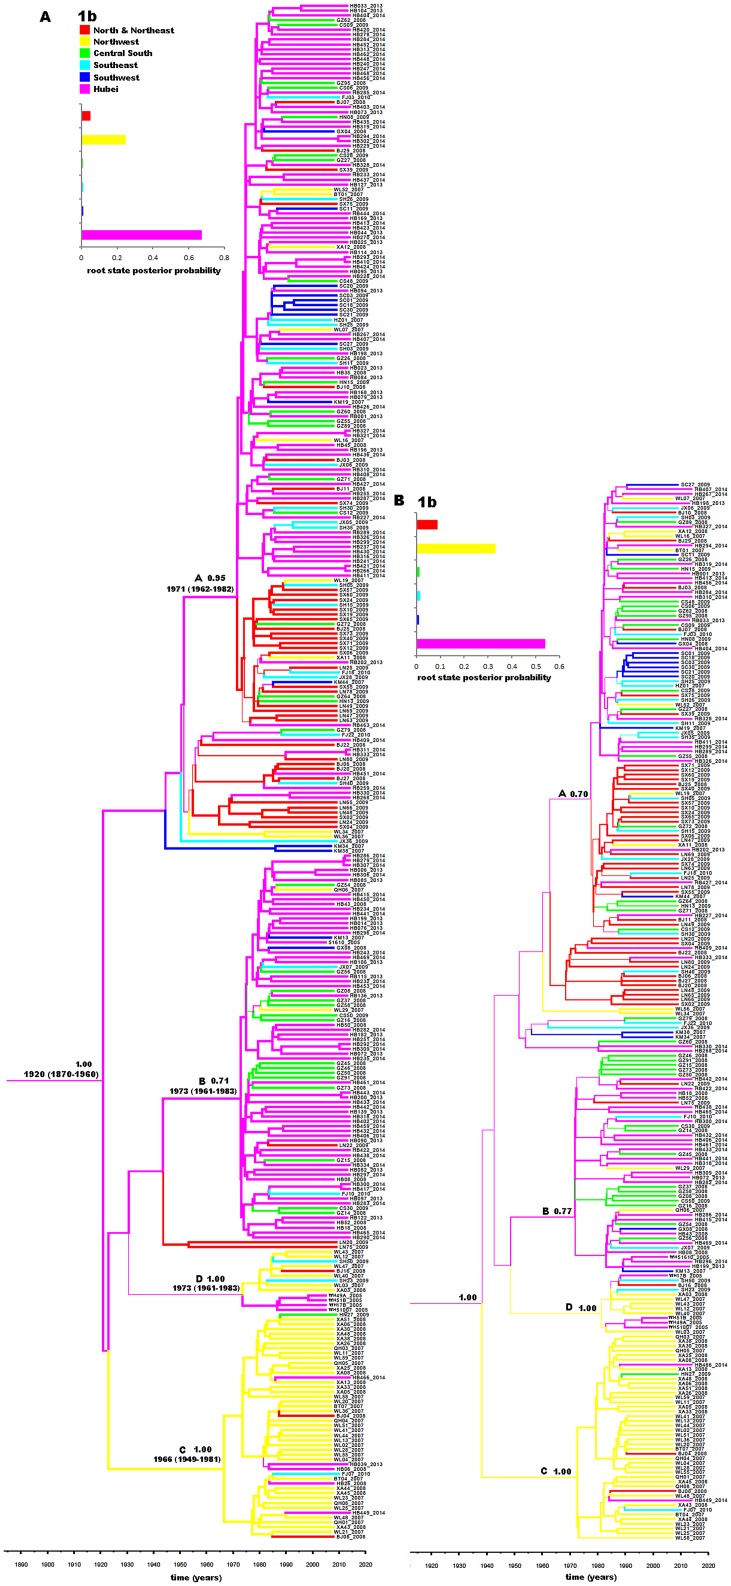
Phylogeographic tree reconstructed with the partial Core-E1 sequences of subtype 1b isolates.(A) A total of 333 subtype 1b sequences were used to generate the phylogeographic tree: 147 obtained in this study, indicated by HB and three digits (e.g., HB001), 5 from intravenous drug users (IDUs) in Wuhan city of Hubei Province, indicated by WH and several digits and/or characters [13], and 180 from blood donors from the 17 provinces and municipalities in China, including 15 from Hubei Province, which were named by HB and two digits (e.g., HB01) [5]. Branches are colored according to the most probable location state of their descendent nodes. Branch width is proportional to the probability value of the inferred ancestral geographical state. To the upper left of the tree are its root location state posterior probability distribution and the color scheme for different geographic origins. At the respective nodes, posterior probabilities of >0.70 are shown along with the estimated time points of the origin for the nodes. Below the tree is a time scale, which indicates the time of HCV origin and evolution. The four intra-genotypic lineages discussed in the main text are labeled A, B, C, and D. (B) The same phylogeographic tree was generated on the basis of the aforementioned dataset in panel A except that only 49 Hubei sequences were included, which were selected according to a scenario that no more than 3 sequences were retained from each phylogenetic cluster of the phylogeographic tree in panel A.